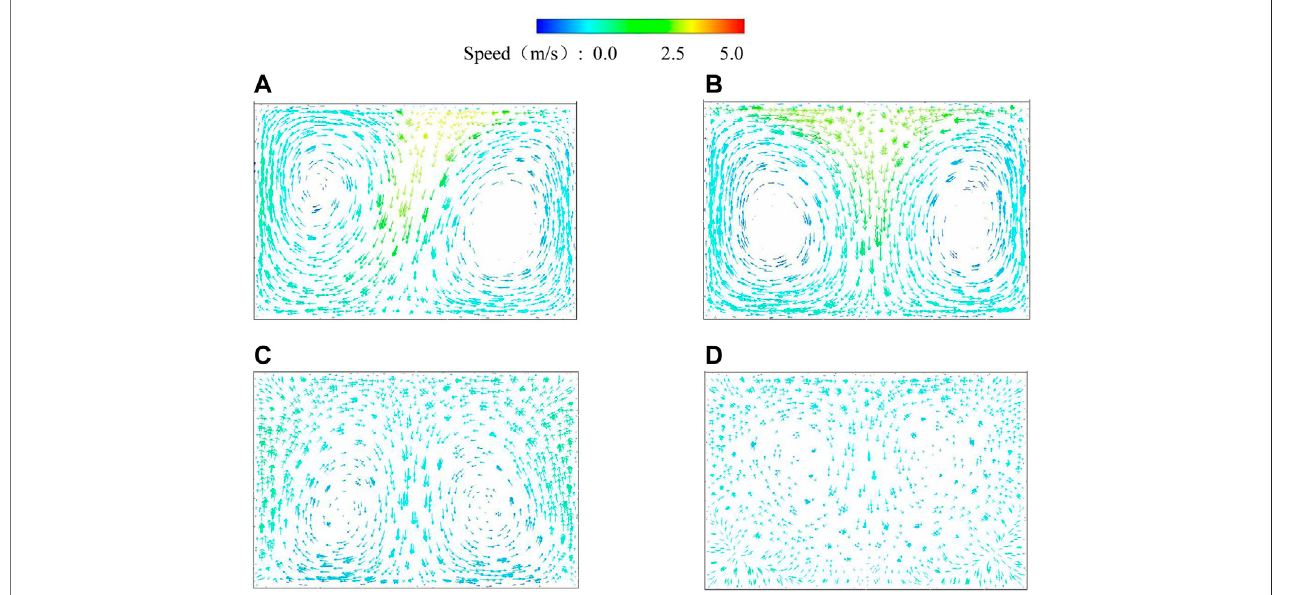
FIGURE 7 | Vector diagram of cross-section velocity: (A) case 1, (B) case 2, (C) case 3, and (D) case 4.